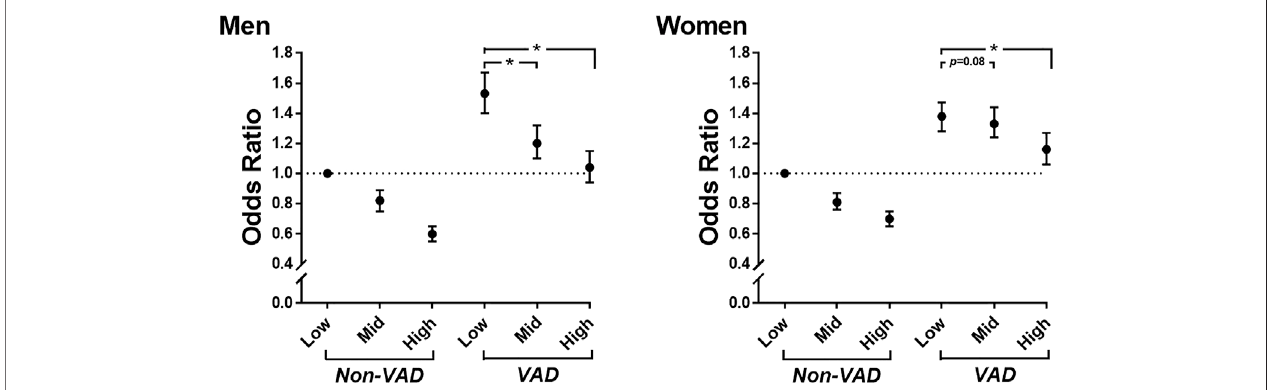
FIGURE3| Oddsratiosforhypertensionaccordingtosex-speci fi ctertilesofrHGSandVAD.Adjustedforage,drinking,smoking,educationlevel,totalcholesterol, diabetes mellitus, and PA-time. rHGS, relative handgrip strength; VAD, visceral adipose dysfunction; PA-time, total time (min/week) expended for participating regularly in any sports or exercise to the point of sweating; *, p <